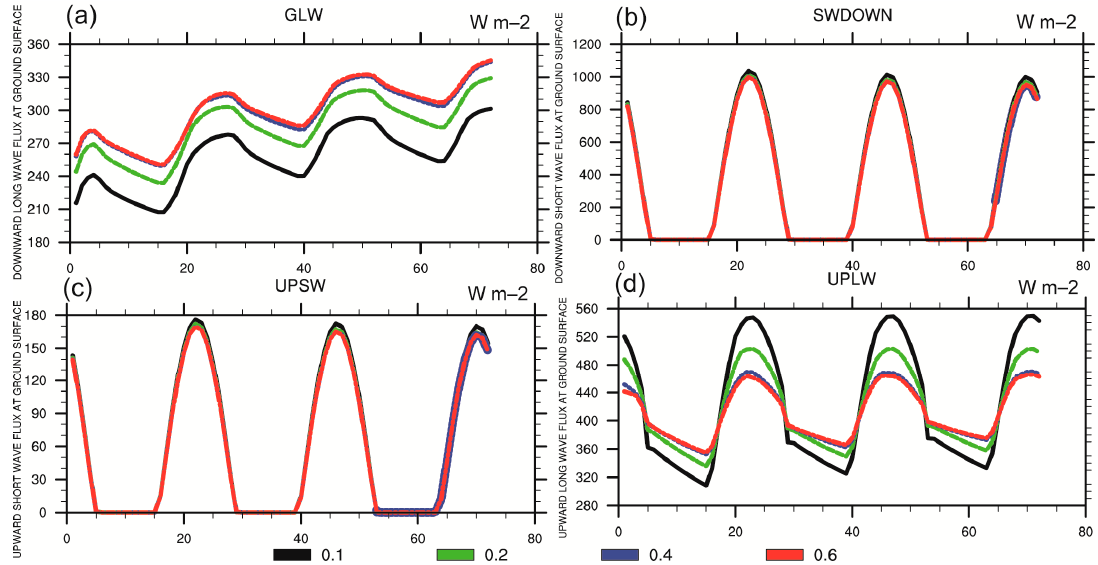
Figure 5. The ( a ) downward long-wave radiation fluxes (GLW); ( b ) downward short-wave radiation (SWDOWN); ( c ) upward short-wave radiation (UPSW) and ( d ) upward long-wave radiation (UPLW) of the SCM simulations under different soil moisture initial conditions. The black line represents the soil moisture equal to 0.1; the green line represents the soil moisture equal to 0.2; the blue line represents the soil moisture equal to 0.4; and the red line represents the soil moisture equal to 0.6. The x -axis represents the number of hours since the simulation.